Question: Condense the content of this figure into a single sentence.
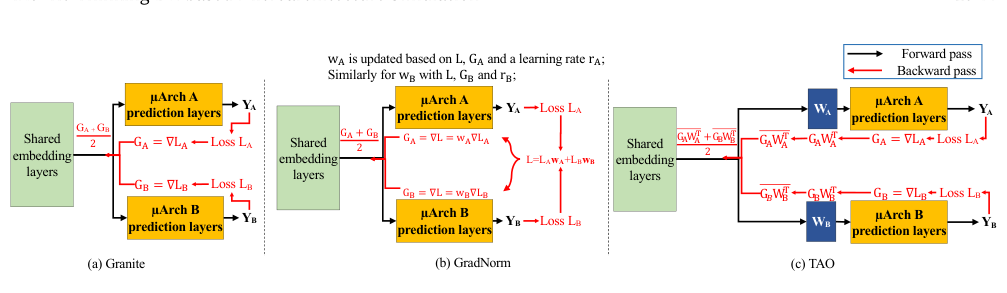
Answer: Comparison of multi-architecture training paradigm.